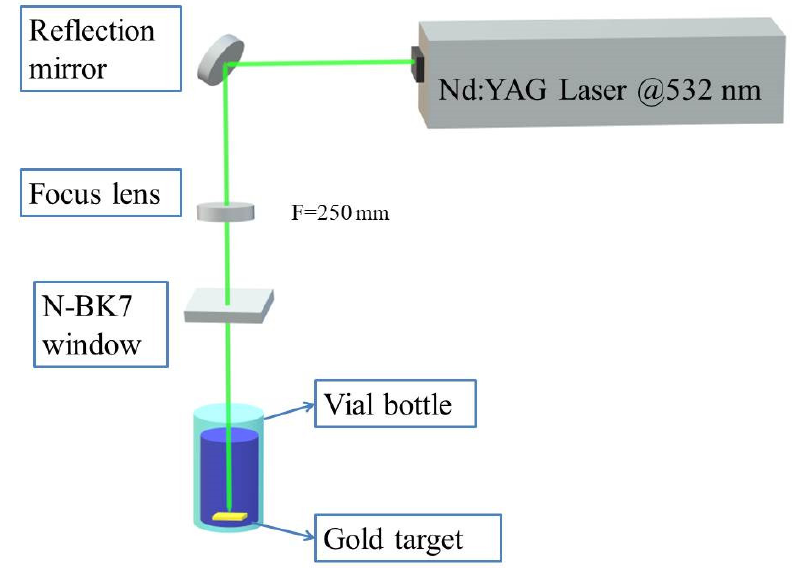
Figure 1. A schematic diagram of the LASiS method procedure for the synthesis of Au NPs.